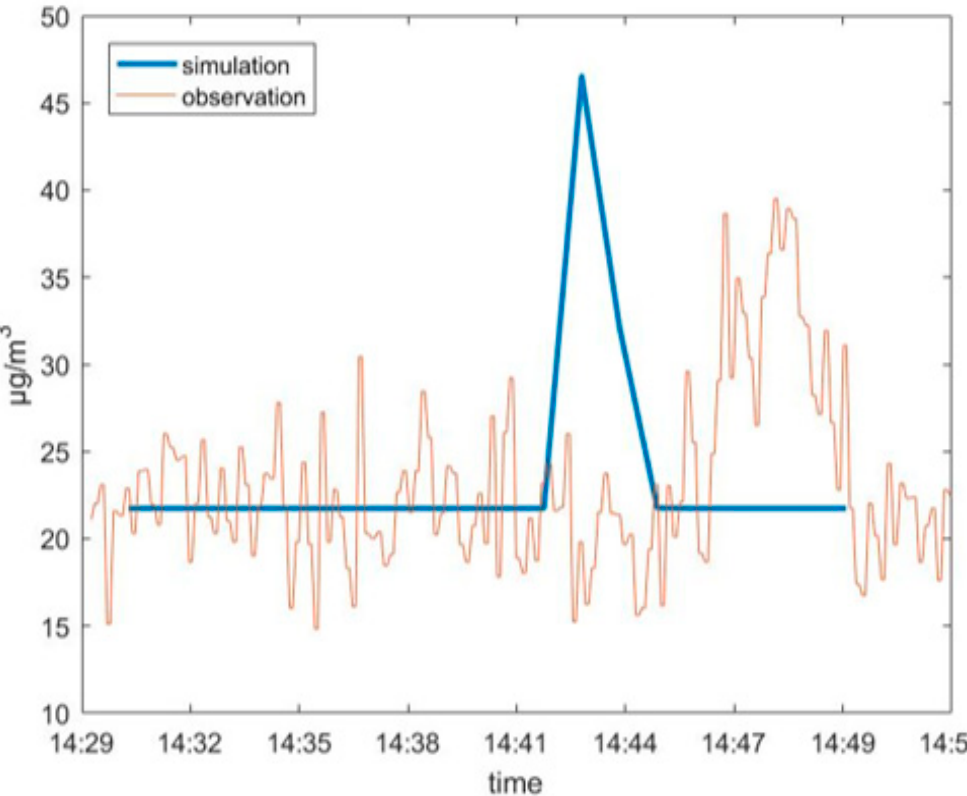
Figure 3. Vessel B’s SO 2 time-series comparison of simulations and Figure 3. Vessel B ’s SO 2 time-series comparison of simulations and observations.